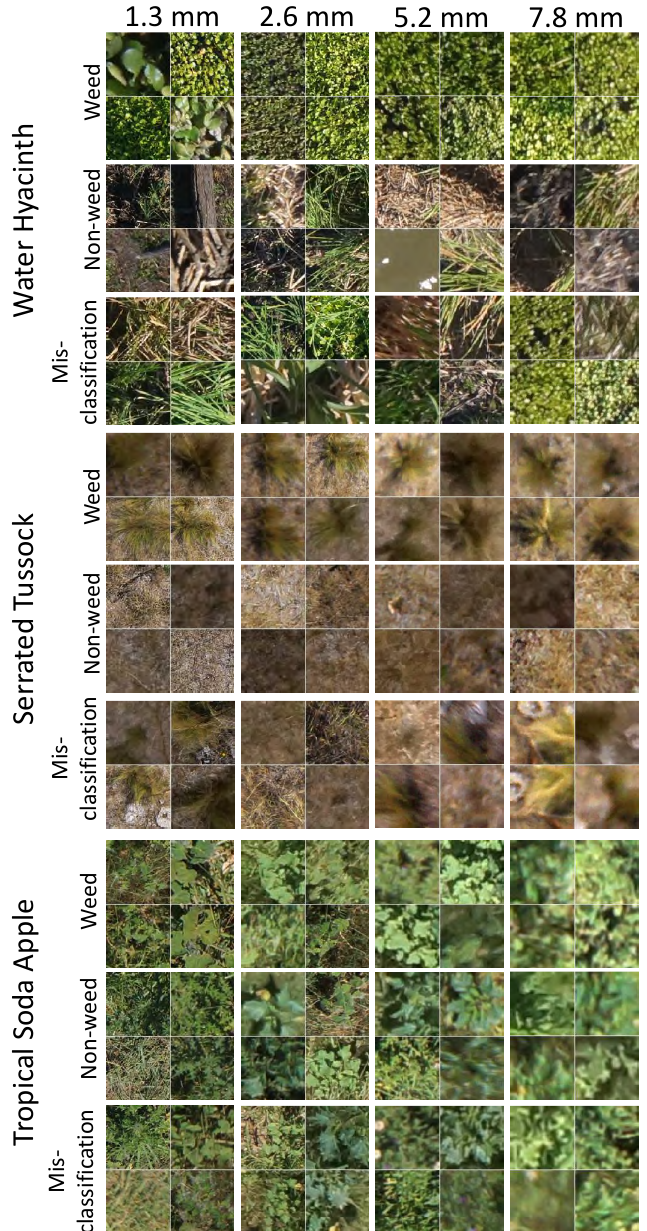
Figure 8. Qualitative results: examples of correctly classified weeds, non-weeds and mis-classification for water hyacinth, serrated tussock and tropical soda apple at different pixel